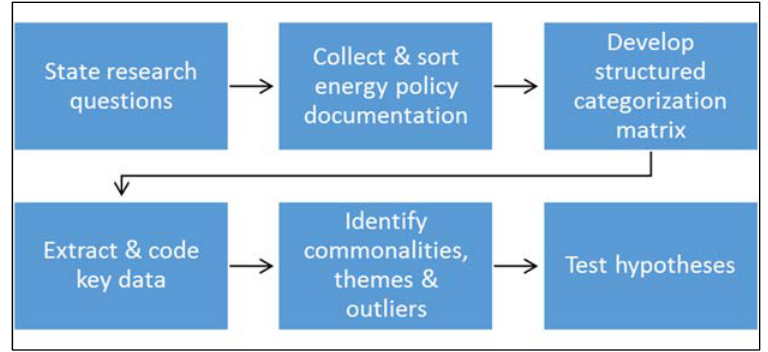
Figure 1. QCA Process Flow.